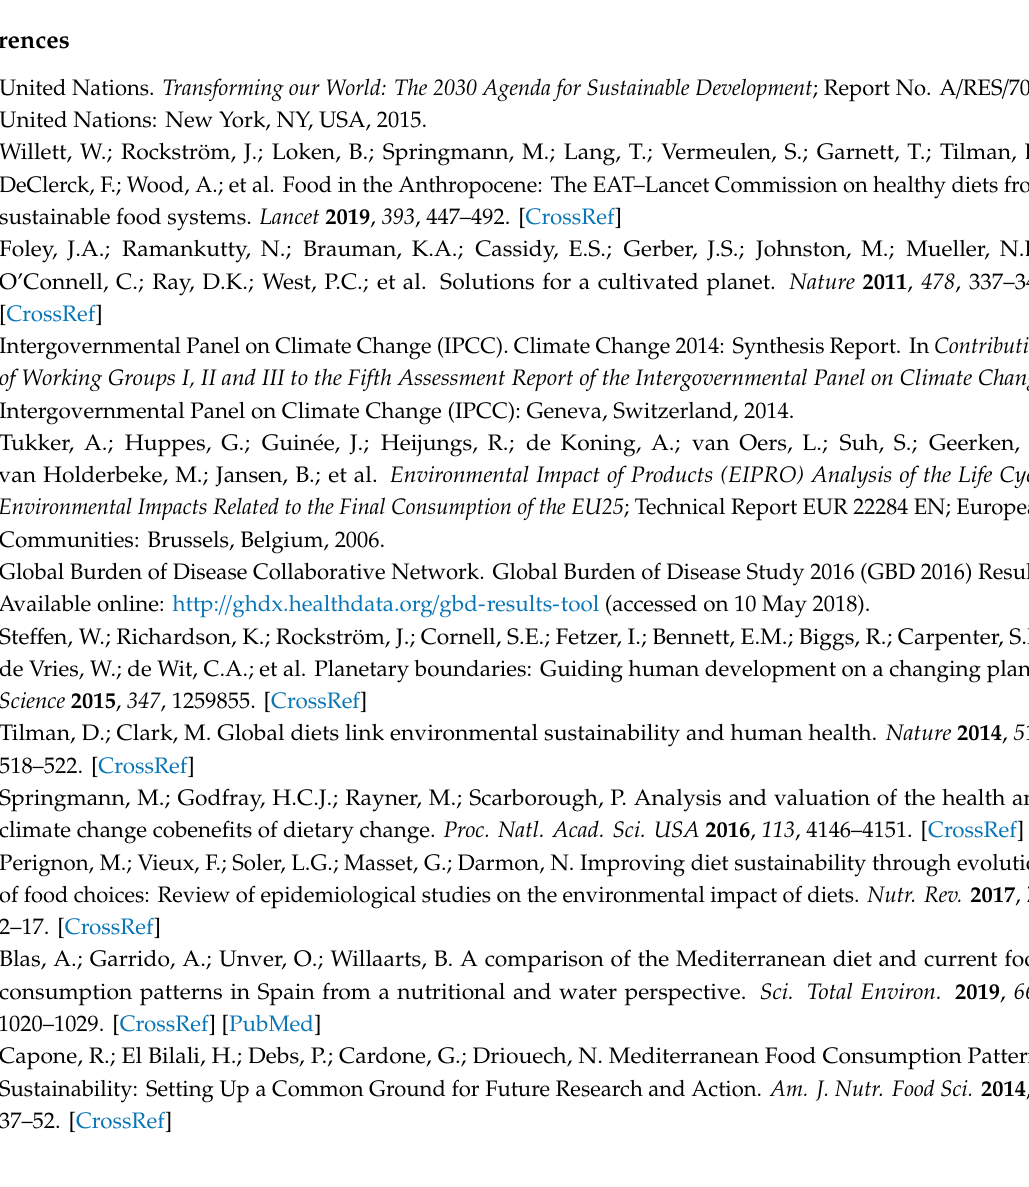
Table S1: Raw data and parameter values used in the health impact assessment model. Table S2: Raw data and parameter values used in the nutrition quality assessment. Table S3: Characterization factors for di ff erent food groups giving environmental footprint per kg of a food item used for environmental assessment. Table S4: Detailed results on health impact assessment including 95% value for indicators. Table S5: Contribution of each food group to the total environmental footprint of daily average per capita Swiss diet. Table S6: Contribution of di ff erent food group to the total expenditure on daily average per capita Swiss